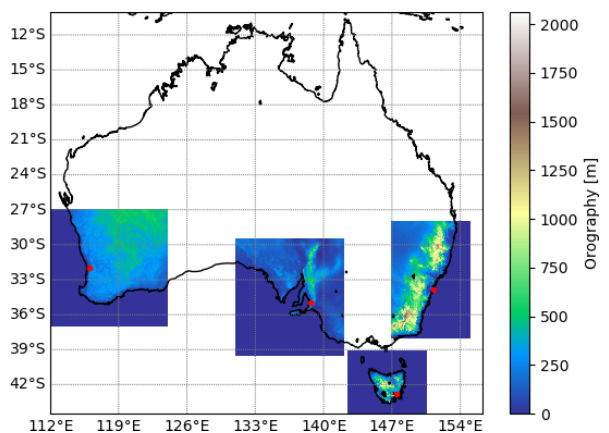
Figure 1. Domains of BARRA-C, (left to right) BARRA-PH (over Perth), BARRA-AD (Adelaide), BARRA-TA (Tasmania), and BARRA-SY (Sydney), showing the modelled orography. Red cir- cles indicate the locations of the state capital